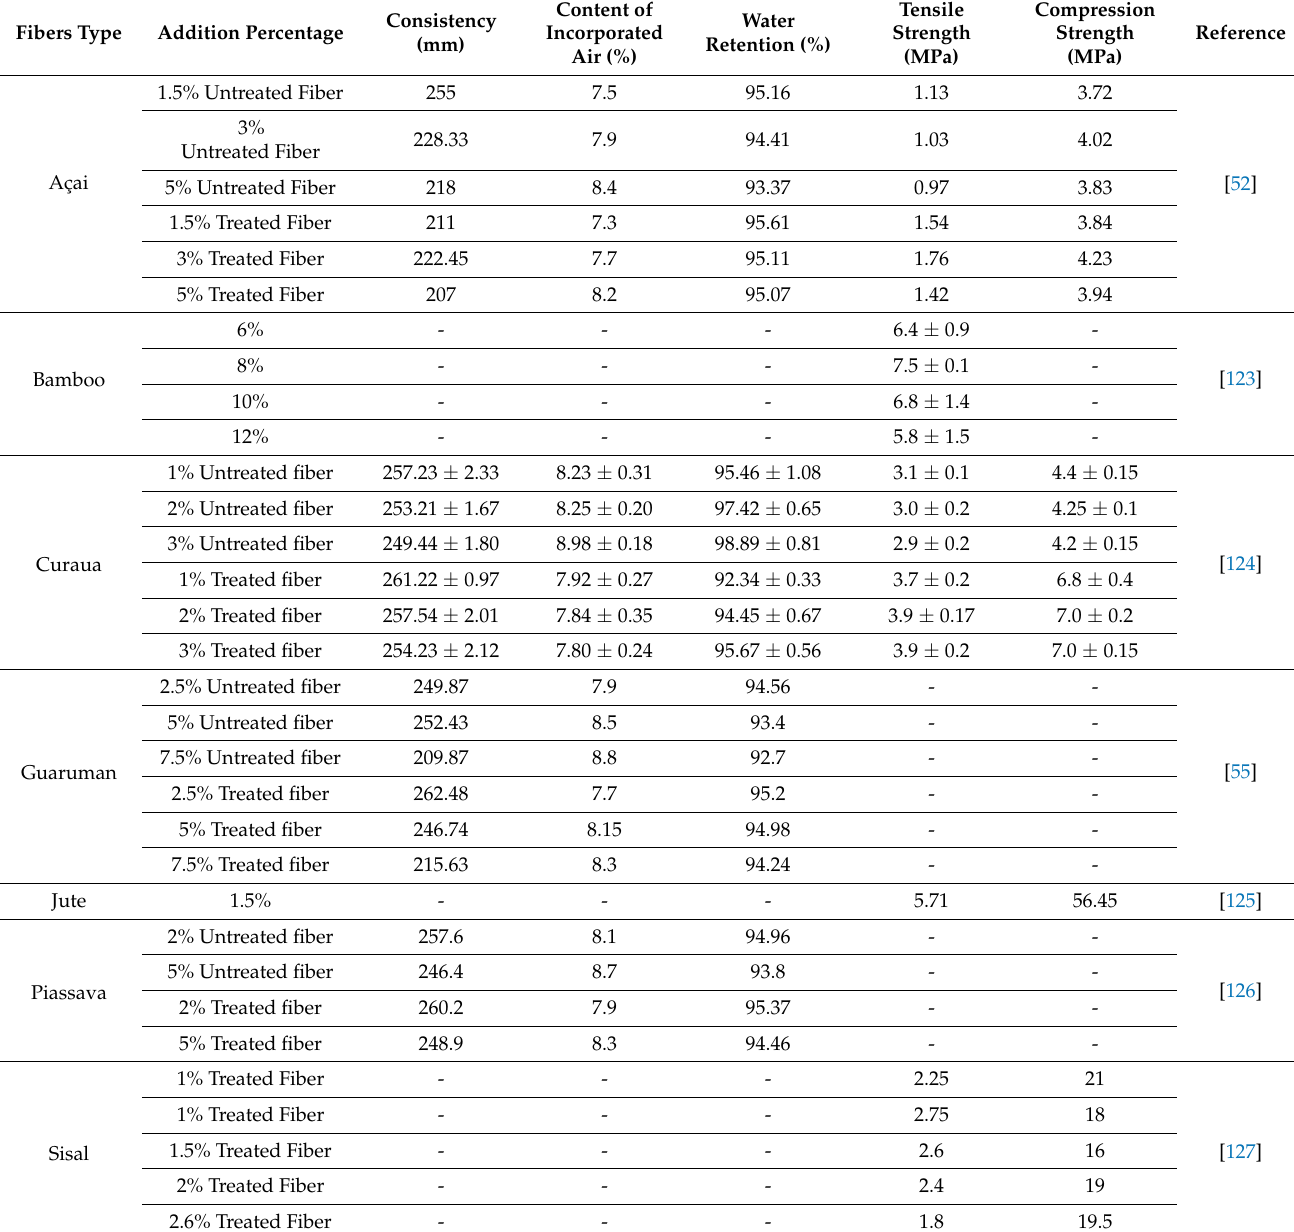
Table 4. Properties of the composite with Amazonian